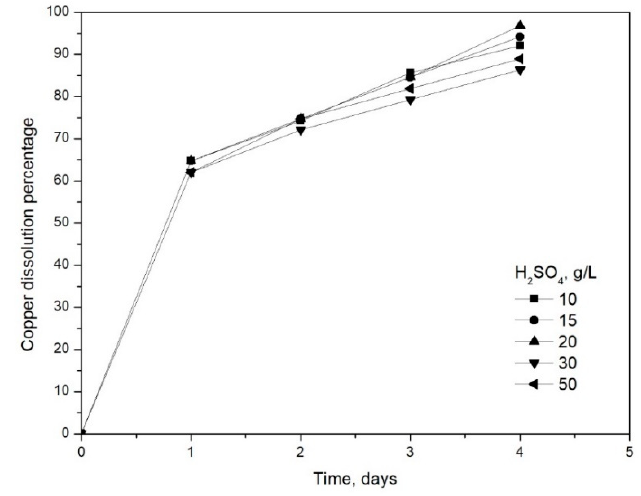
Figure 10. Copper recovery curves in leaching with a variation of H 2 SO 4 , 30 g/L NaCl and 4 g/L Fe 3+ under conditions of 1 atm, 22 °C and 400 rpm.